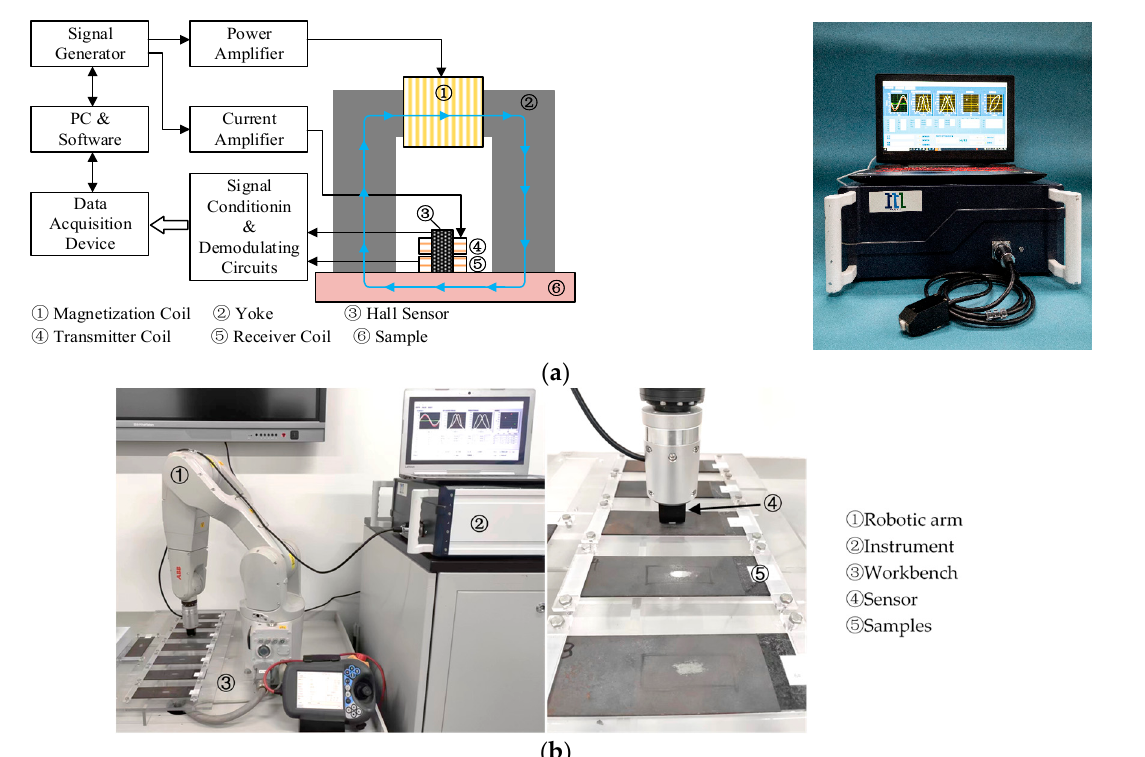
Figure 1. ( a ) Instrument and ( b ) experimental set-up for performing multifunctional micro-magnetic testing.